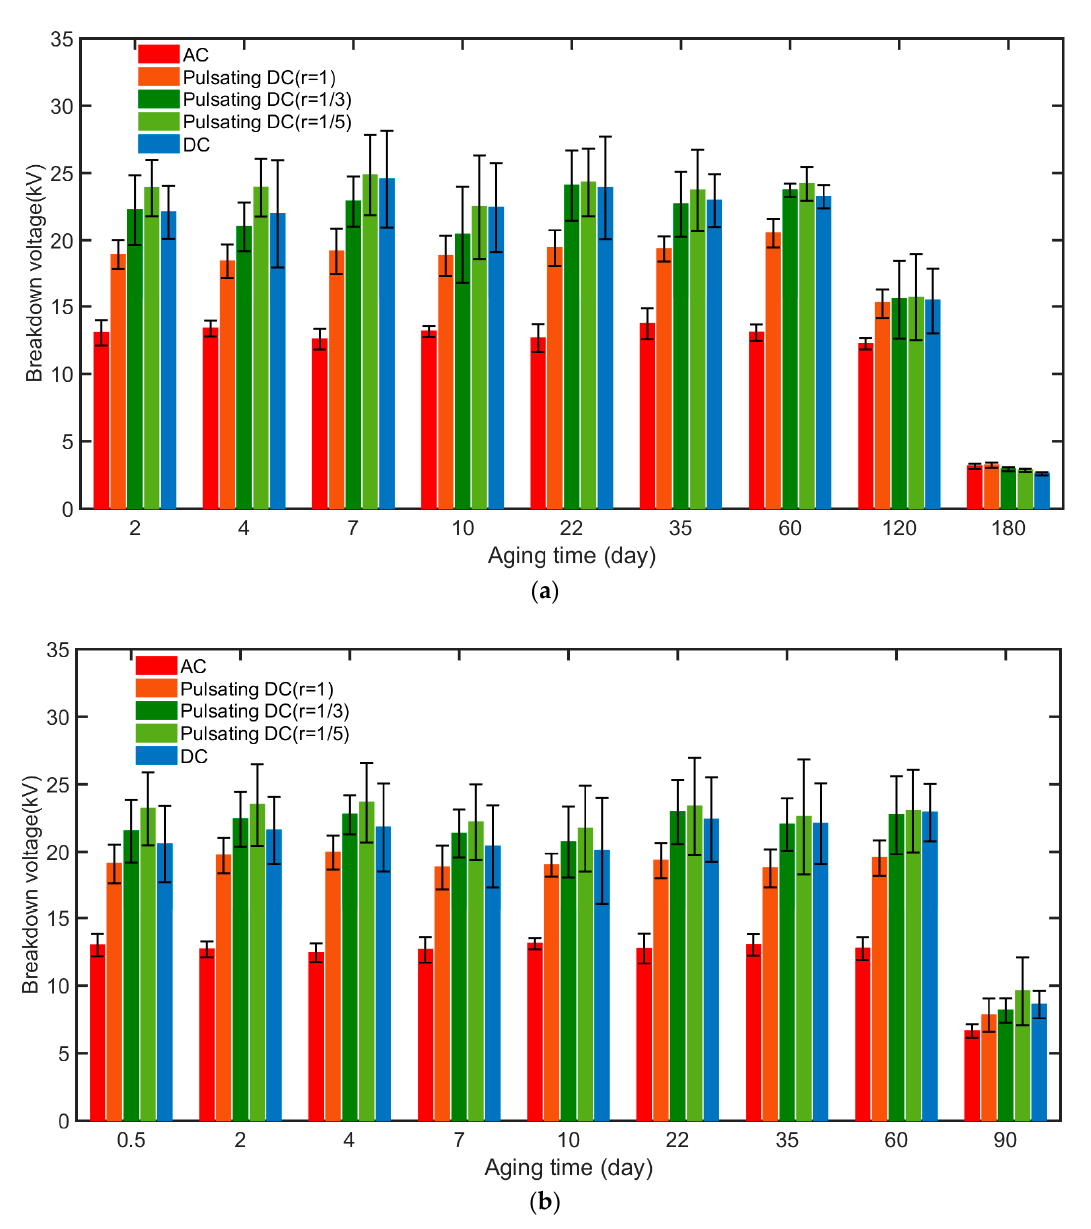
Figure 5. Breakdown voltage of oil-impregnated paper (OIP) after thermal aging with one standard deviation: ( a ) 120 °C; ( b ) 130 °C.